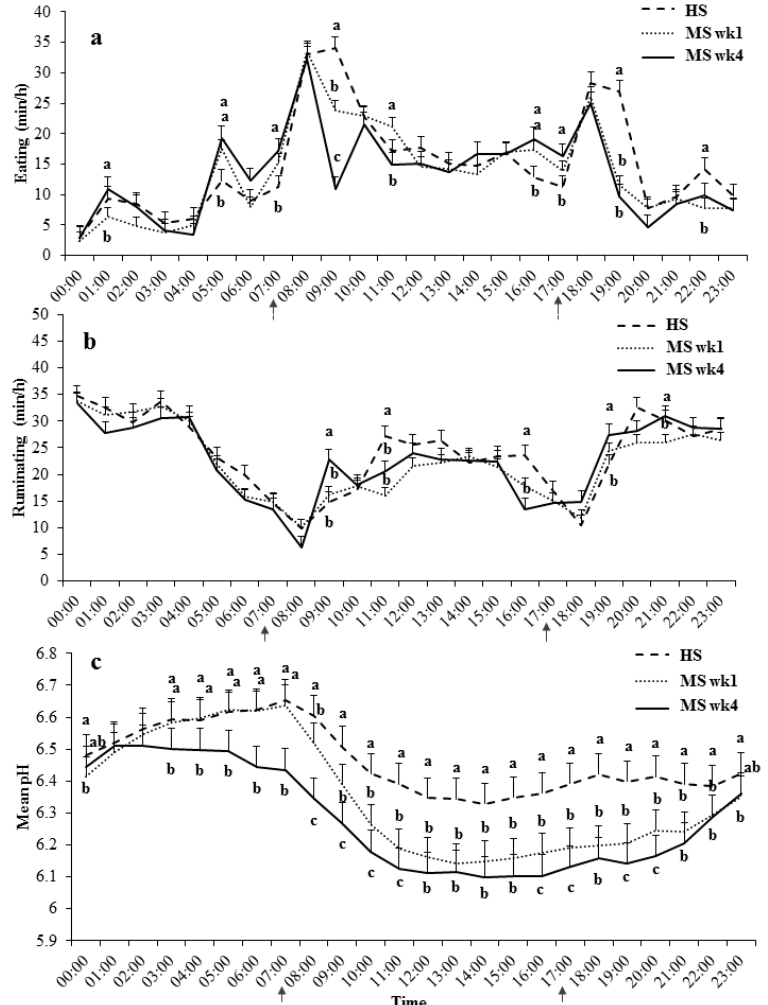
Figure 1. Daily eating ( a ), ruminating activity ( b ), and diurnal reticuloruminal pH dynamics ( c ) in cows fed a 40% concentrate diet with a high content of physical structure (24.4% peNDF > 8 mm DM basis; HS) for one week before being switched to a 60% concentrate diet with moderate physical structure content (17.6% peNDF > 8 mm DM basis; MS). Measurements were conducted during the last four days of HS until the end of MS wk 1, and on three consecutive days of MS wk 4. Arrows indicate times when the fresh feed was delivered (0730 and 1730). Hours with different superscripts differ significantly ( p ≤ 0.05).